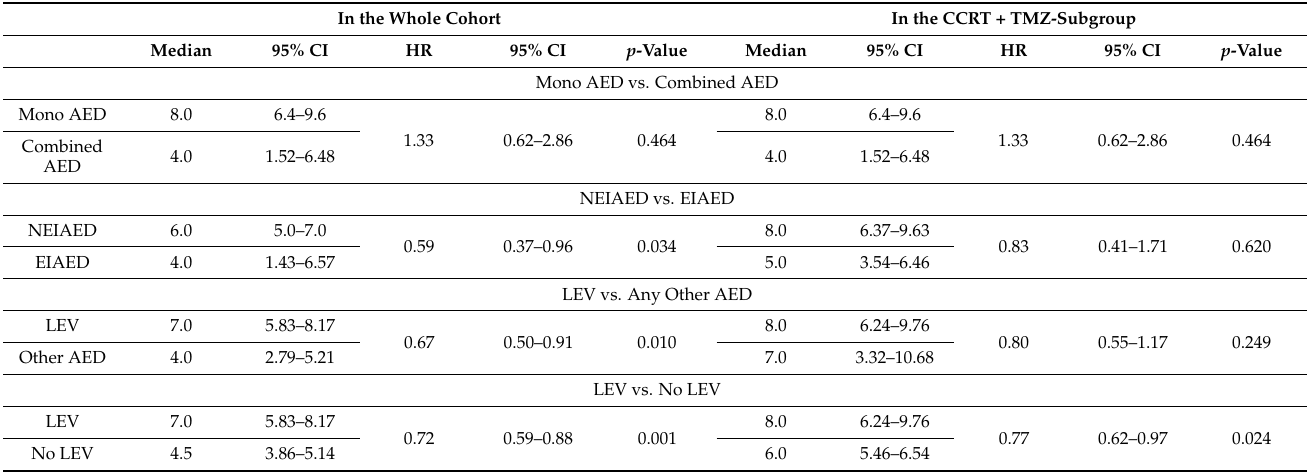
Table 3. PFS values incl. HRs in different AED categories within the whole cohort and subgroup with adjuvant chemoradia- tion with TMZ (CCRT + TMZ-subgroup).